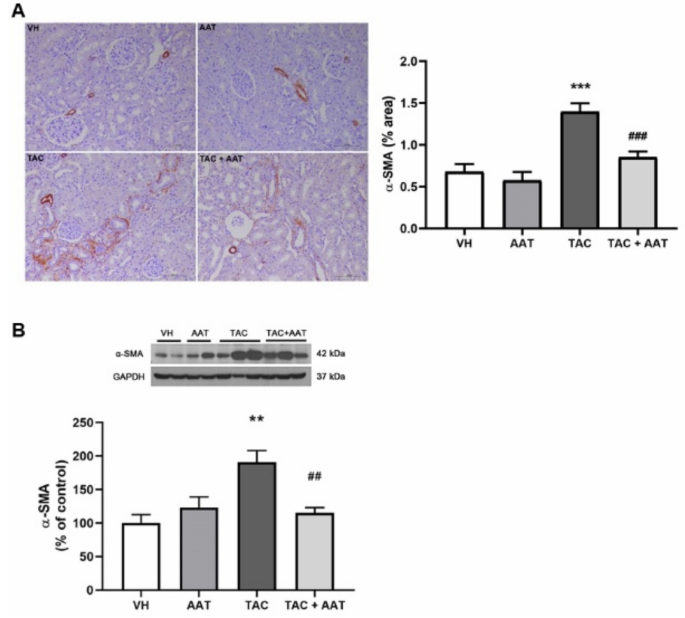
Figure 3. E ff ect of alpha-1 antitrypsin on α -SMA staining and expression in tacrolimus-induced renal injury. ( A ) Immunohistochemical staining for α -SMA (200 × magnification) (Left). Quantitative